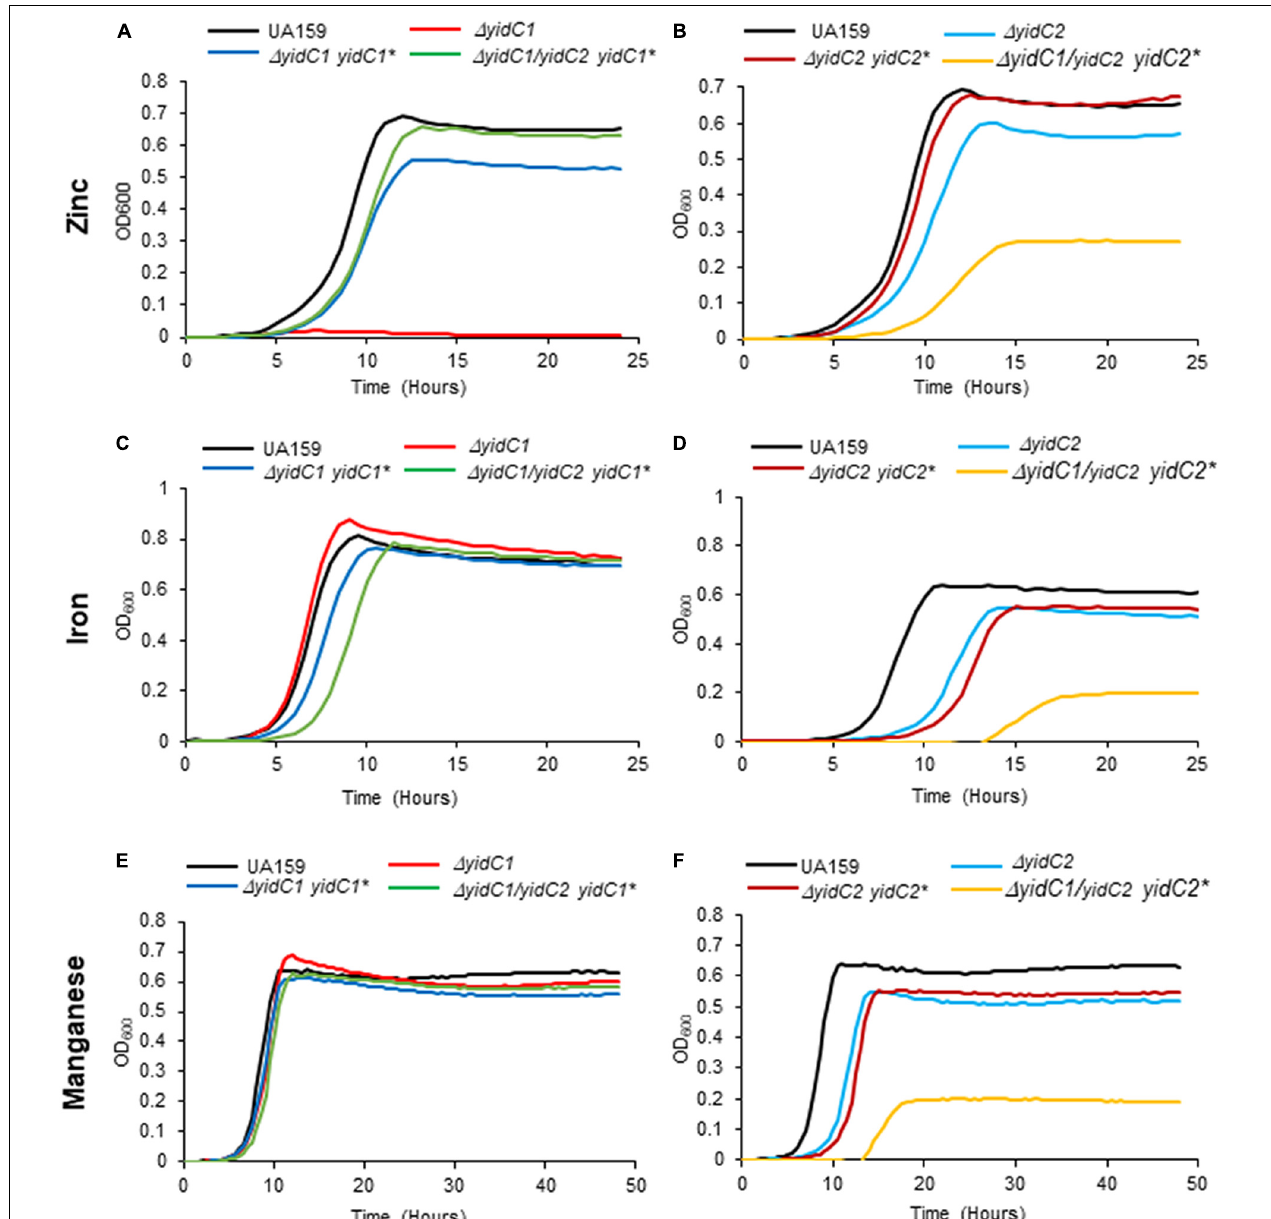
FIGURE 5 | Evaluation of growth of S. mutans wild-type, (cid:49) yidC1 / 2 mutants, and ectopic expression strains under excess transition metal conditions. Growth of the wild-type UA159 parent strain compared to (cid:49) yidC1 (A,C,E) or (cid:49) yidC2 (B,D,F) deletion mutants, and strains complemented by ectopic expression (*) from the gtfA locus of yidC1 or yidC2 in single (cid:49) yidC1/2 or double (cid:49) yidC1/DyidC2 backgrounds. (A,B) Growth in THYE, pH 7, supplemented with 2.5 mM ZnCl 2 under aerating conditions. (C,D) Growth in THYE, pH 7, supplemented with 5 mM MnCl 2 under aerating conditions. (E,F) Growth in THYE, pH 7, supplemented with 5 mM MnCl 2 under aerating conditions. Growth measurements were carried out at least three times with each sample assayed in triplicate. Data shown are mean replicates of an independent experiment.